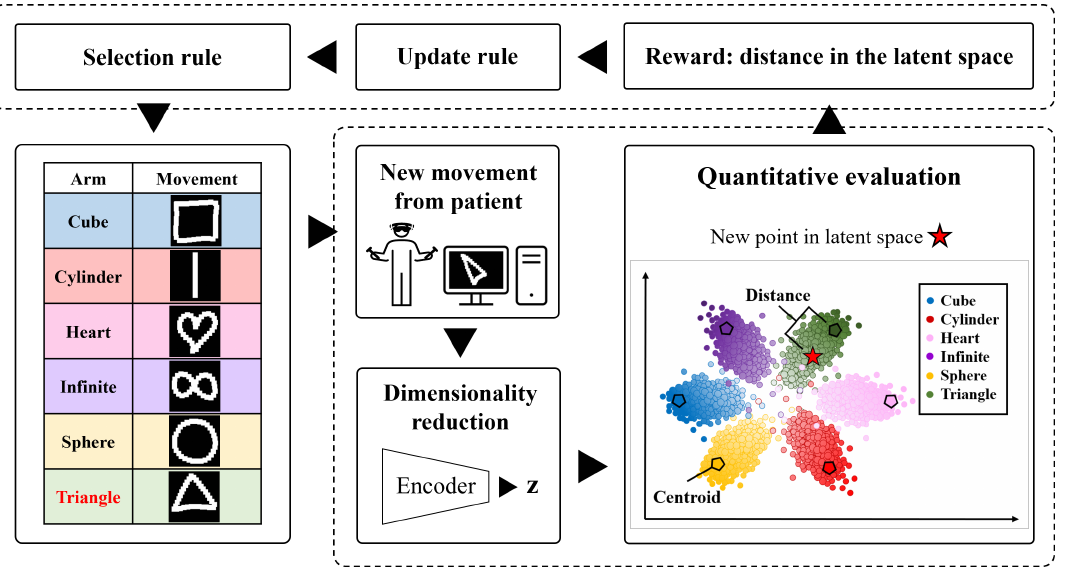
Figure 1. Project Overview. The adversarial autoencoder (AAE) is trained by considering a regular- ization component to create a set of six Gaussian distributions in a latent space. The trained AAE is then fed with a new sample (with Triangle as an example) and represented in the latent space (red cross). Finally, a distance metric is computed between a target (green centroid) and used as a reward for the MAB